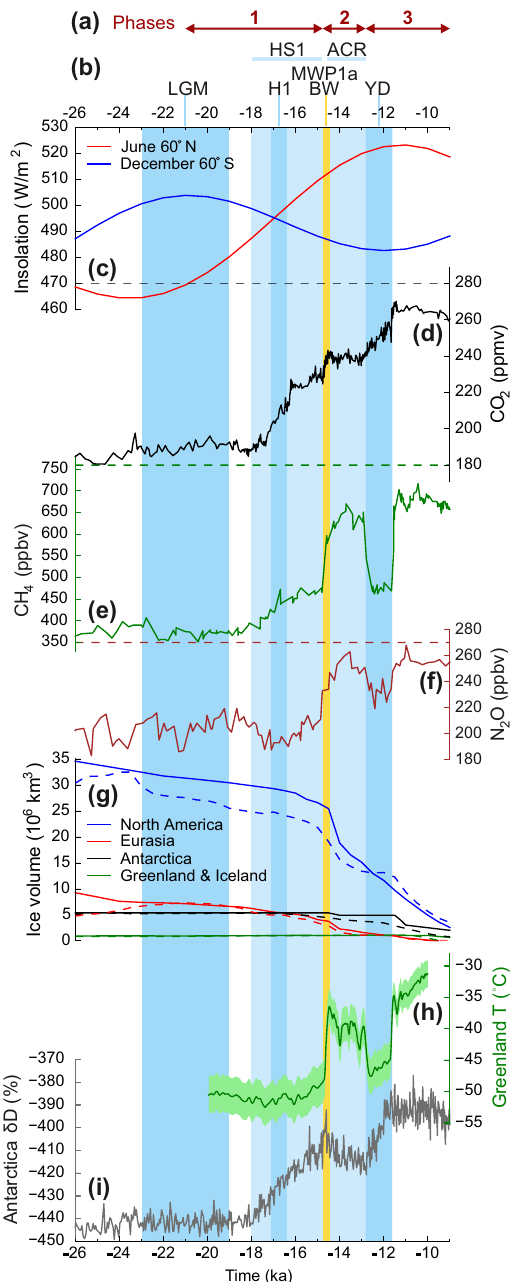
Figure 1. The last deglaciation: forcings and events. (a) The three phases of the Core experiment version 1 (Sect. 4). (b) Climate events/periods discussed in the text; Last Glacial Maximum (LGM; 23–19ka as according to the EPILOG definition; Mix et al., 2001), Heinrich Stadial 1 (HS1), Heinrich Event 1 (H1), Bølling Warming (BW) and Meltwater Pulse 1a (MWP1a), Antarctic Cold Reversal (ACR) and the Younger Dryas cooling (YD). (c) June insolation at 60 ◦ N and December insolation at 60 ◦ S (Berger, 1978). (d) Atmospheric carbon dioxide concentration (recent composite of EPICA Dome C, Vostok, Taylor Dome, Siple Dome and West Antarctic Ice Sheet Divide records, Antarctica; Bereiter et al., 2015); black dashed line shows preindustrial concentration. (e) Atmospheric methane concentration (EPICA Dome C, Antarctica; Loulergue et al., 2008); green dashed line shows preindustrial concentration. (f) Atmospheric nitrous oxide concen- tration (Talos Dome, Antarctica; Schilt et al., 2010); brown dashed line shows preindustrial concentration. (g) Volume of the ice sheets according to the ICE-6G_C reconstruction (solid lines; Argus et al., 2014; Peltier et al., 2015) and the GLAC-1D reconstruction (dashed lines; Briggs et al., 2014; Tarasov et al., 2012; Tarasov and Peltier, 2002). Associated meltwater scenarios melt-uniform and melt-routed (see Sect. 2.5) are consistent with these; all ice mass loss shown is supplied as freshwater to the ocean. (h) Greenland temperature reconstruction with ± 1 σ shaded (averaged GISP2, NEEM and NGRIP records; Buizert et al., 2014). (i) Antarctic δ D (EPICA Dome C; Jouzel et al., 2007). Panels (d–f, h–i) are given on the AICC2012 timescale (Veres et al.,